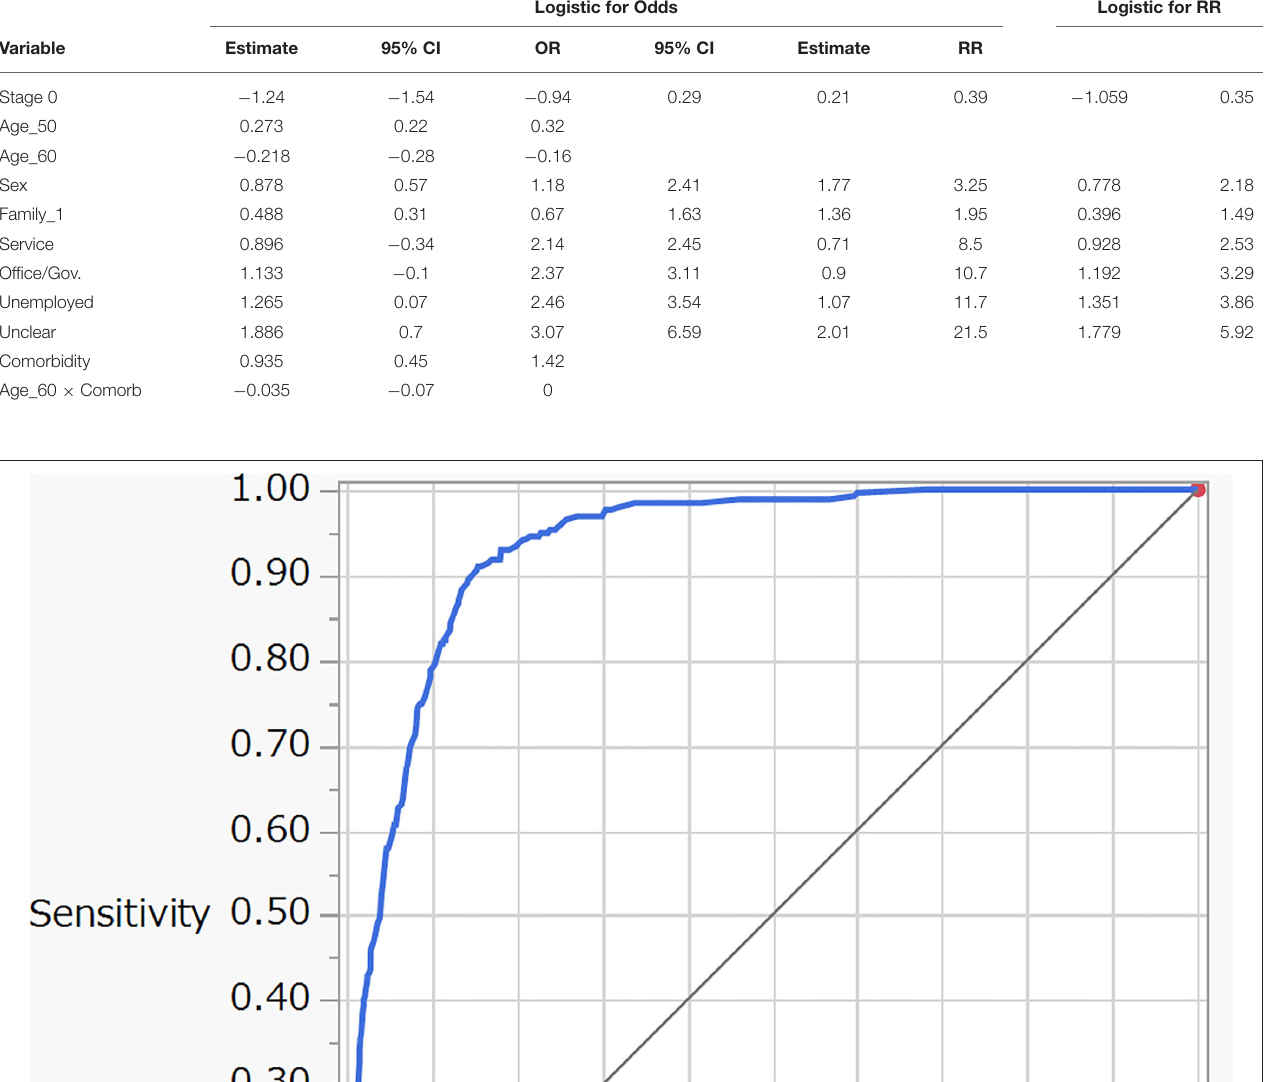
Frontiers in Public Health |